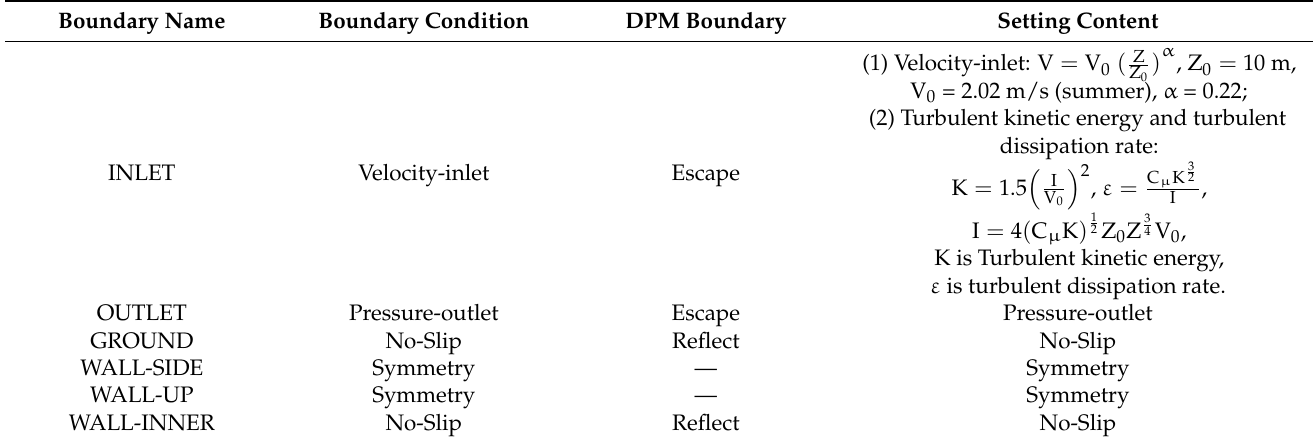
Table 3. Summary of boundary conditions and parameter settings for outdoor calculation